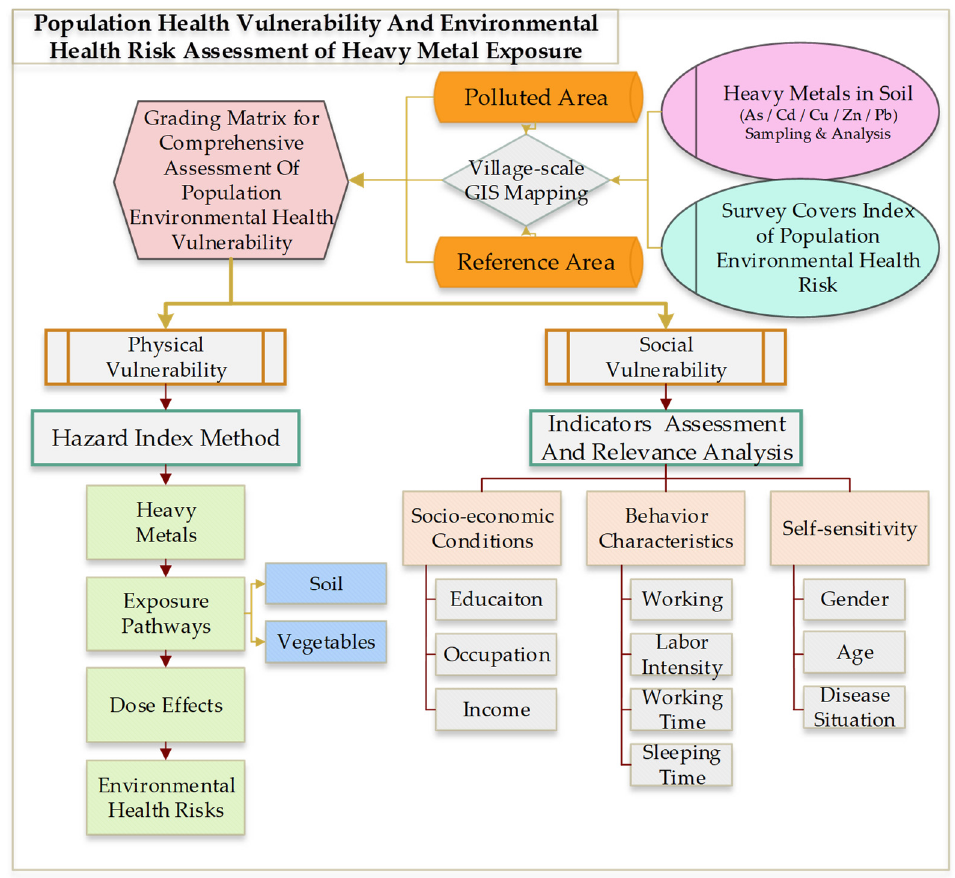
Figure 2. Systematic research solutions for physical–social health vulnerability assessment on heavy metal exposure.